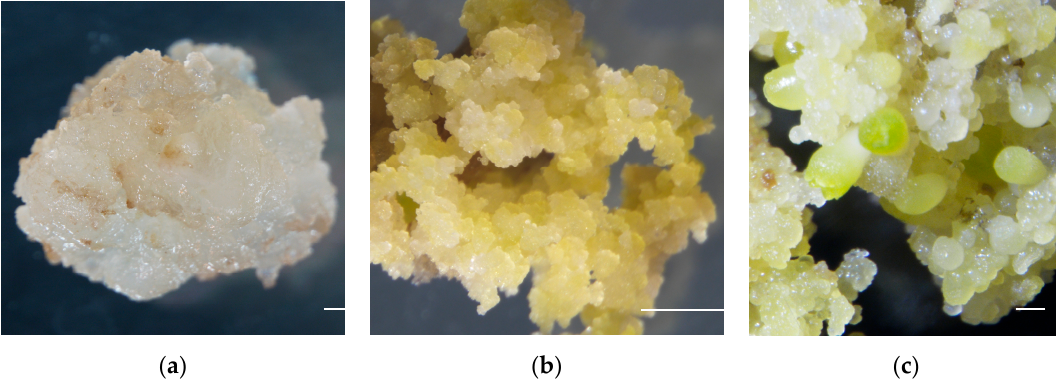
Figure 1. Cultures derived from different developmental stages of cotton somatic embryogenesis (SE) for the purposes of the metabolome and transcriptome assays. ( a ) Nonembryogenic staged calli (NEC); ( b ) primary embryogenic calli (PEC); ( c ) initiation staged embryos with globular-like enriched (GE). Bars = 1 mm.